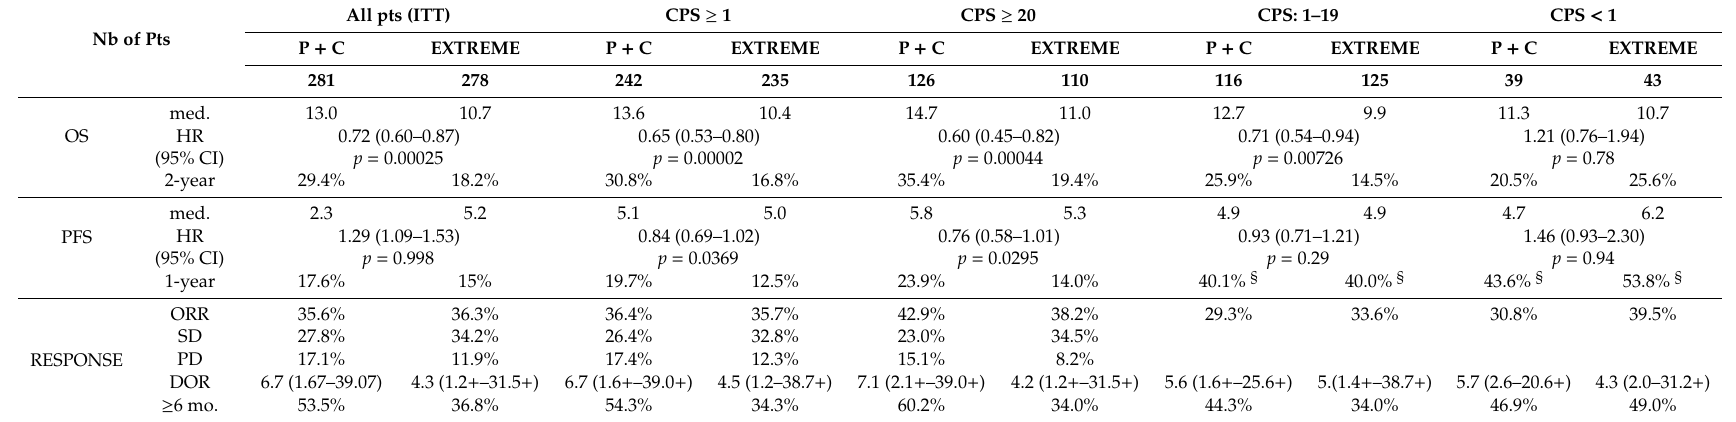
Table 4. KEYNOTE-048: Pembrolizumab + Chemotherapy (C) vs. EXTREME according to